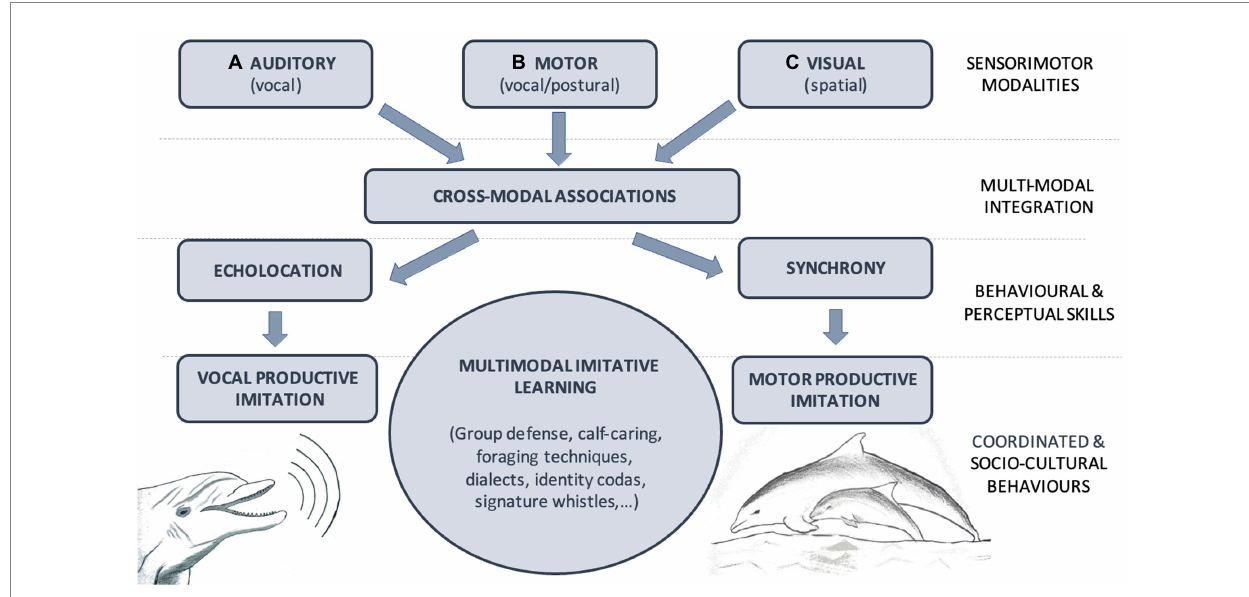
FIGURE 1 Model for multimodal imitation capacity in cetaceans. Cetaceans uses different Sensorimotor Modalities to sense and enact in their environment. (A) Auditory system allows the perception of others’ vocalizations and singing (vocal), (B) Motor system enable the production of vocalizations, songs and the control of body posture (vocal/postural) while (C) Visual system is crucial for the observation of others’ body posture during group behaviors for instance (spatial). Those sensorimotor modalities are integrated by cross-modal associative learning. In individual organism, these multimodal associations underly the consolidation of Behavioral and Perceptual Skills , such as (a) echolocation and (b) synchrony. Multimodal imitative learning is proposed to be a fundamental mechanism that give rise to complex and idiosyncratic Coordinated and Socio-Cultural Behaviors that characterized most cetacean